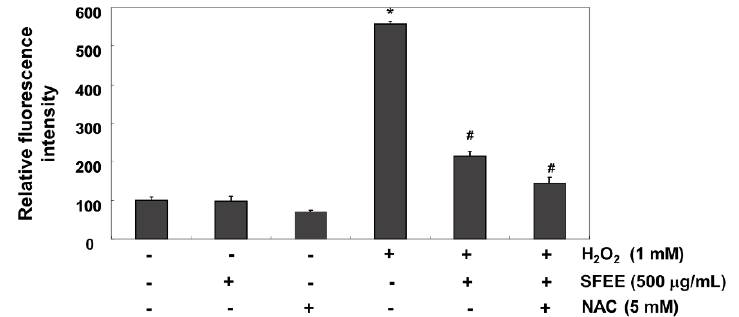
Figure 3. Effects of Schisandrae Fructus ethanol extract on H 2 O 2 -induced reactive oxygen species (ROS) generation in C2C12 cells. C2C12 cells were pretreated with 500 μg/mL SFEE and/or 5 mM N-acetylcysteine (NAC) for 1 h and then stimulated with or without 1 mM H 2 O 2 for 6 h. The cells were incubated at 37 °C in the dark for 20 min with new culture medium containing 10 μM 2′,7′-dichlorofluorescein diacetate (DCF-DA) to monitor ROS production. ROS generation was measured by flow cytometry. The results are mean ± SD values obtained from three independent experiments ( * p < 0.05 compared with control group; # p < 0.05 compared with H 2 O 2 -treated group). SFEE, Schisandrae Fructus ethanol extract.